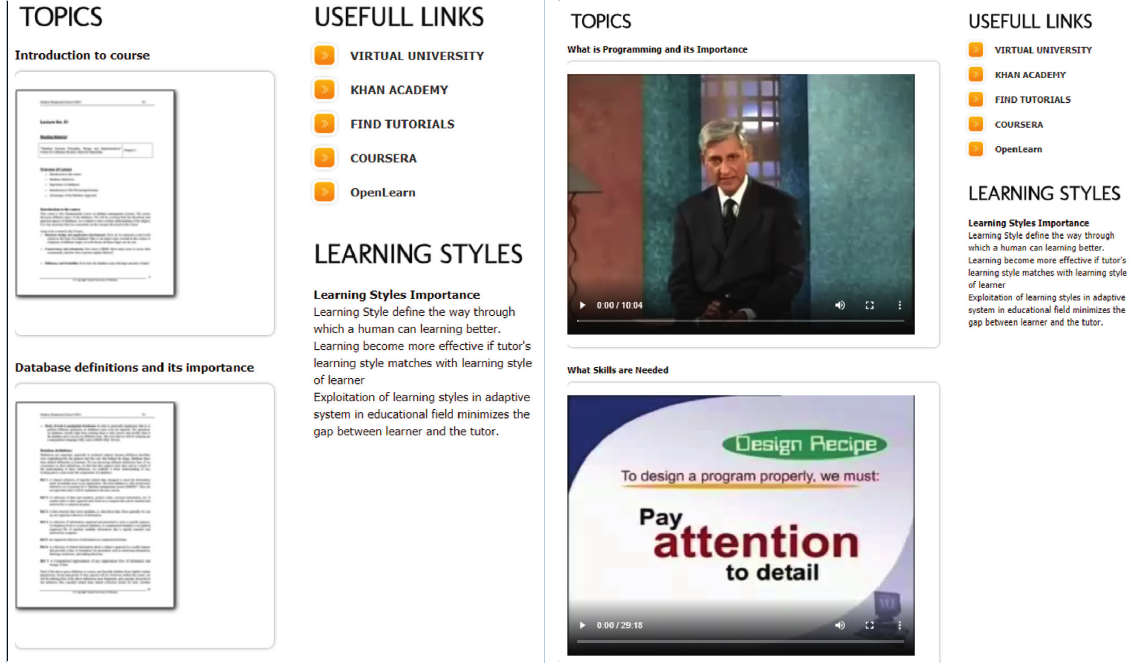
Figure 4: Interface for visual and written